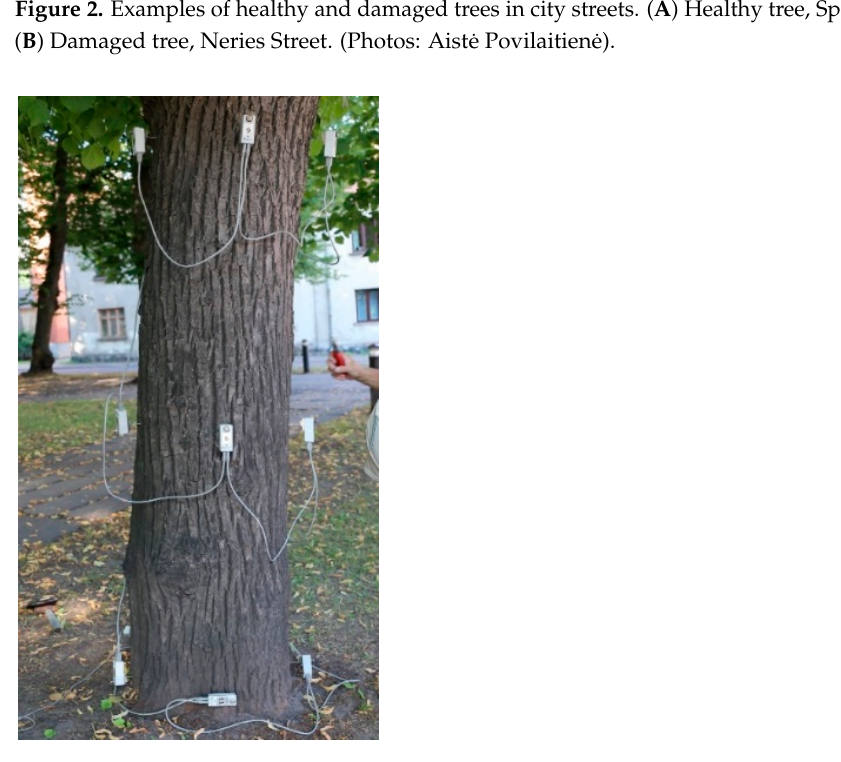
Figure 3. The use of acoustic tool ARBOTOM 3D on standing small-leaved lime trees (Photo: Aist ė Povilaitien ė ).